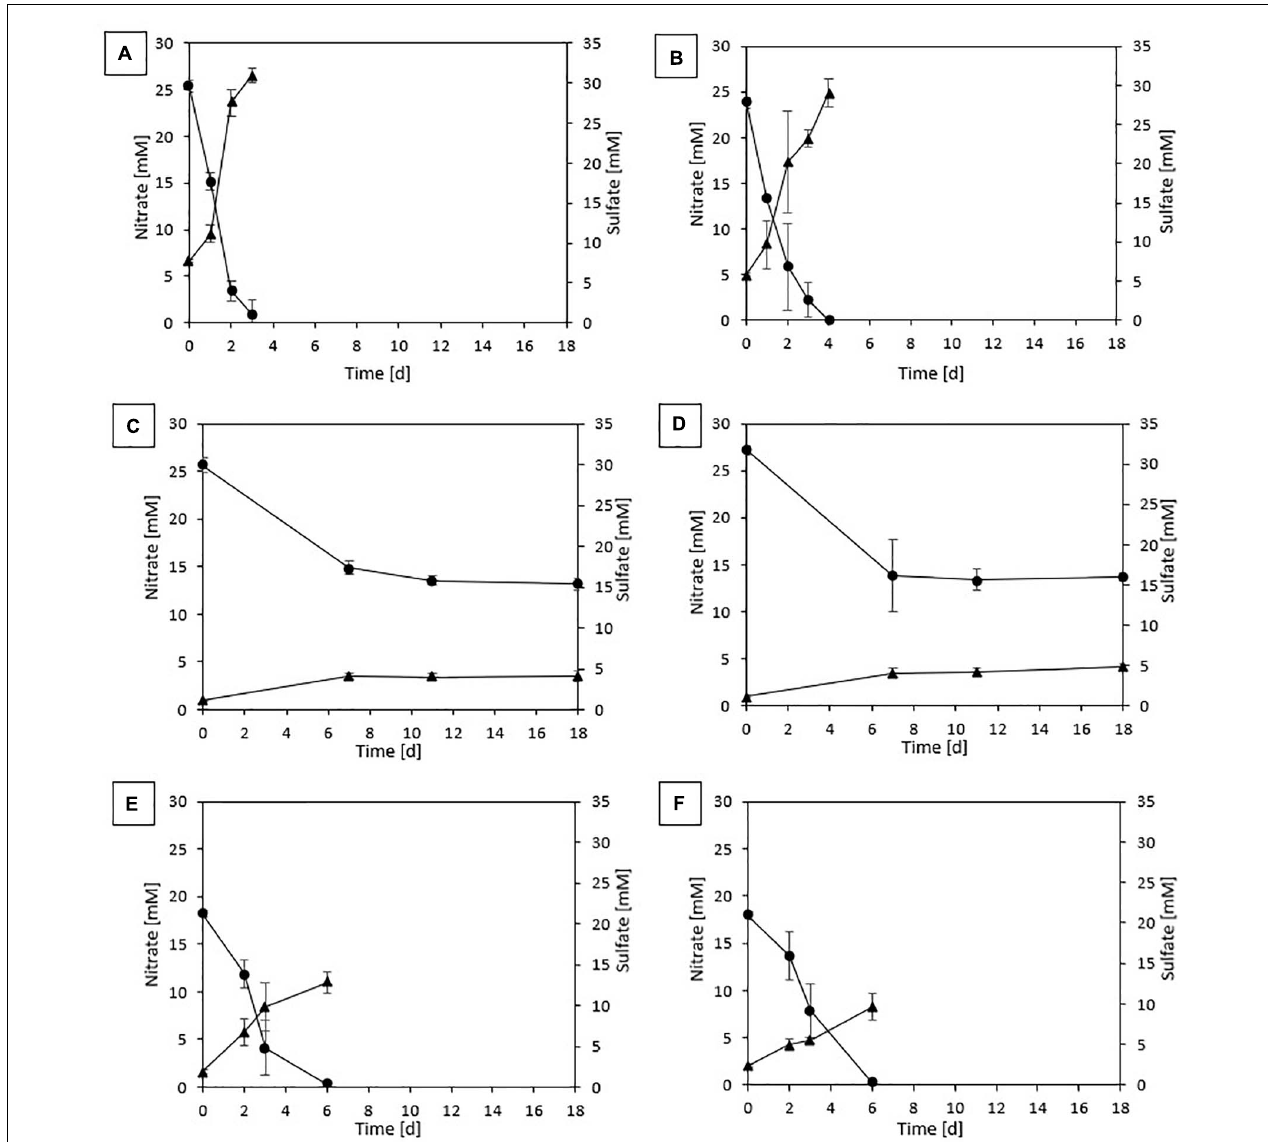
Figure 1 | Profile of NO 3 − ( • ) and SO 42 − ( (cid:78) ) of the last transfer in (A) ThEnr with DS, (B) ThEnr with GS, (C) PyEnr with DS, (D) PyEnr with GS, (E) S 0 Enr with DS, and (F) S 0 Enr with